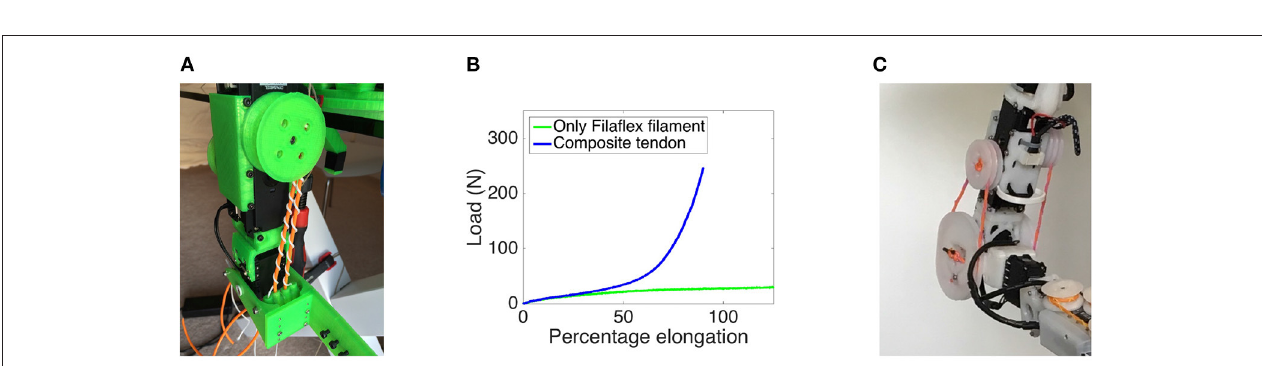
FIGURE 2 | The structural layout of the GummiArm v1.0, seen from the front (A) , side (B) , and top (C) . The 7 joint axes ( E z ) are indicated with thick blue arrows. The tendons are shown as orange lines, while the servo pulleys are highlighted in green (8 shown, corresponding to the 4 out of 5 antagonist joints). Resting pose shown (zero degrees on all joints). Note that the structure and servos corresponding to the shoulder yaw joint are not shown for clarity.